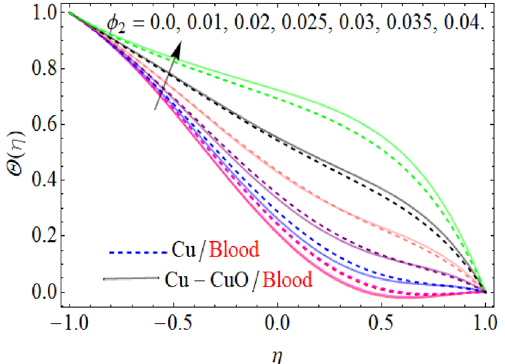
Figure 4. φ 2 influence on the θ(η) .